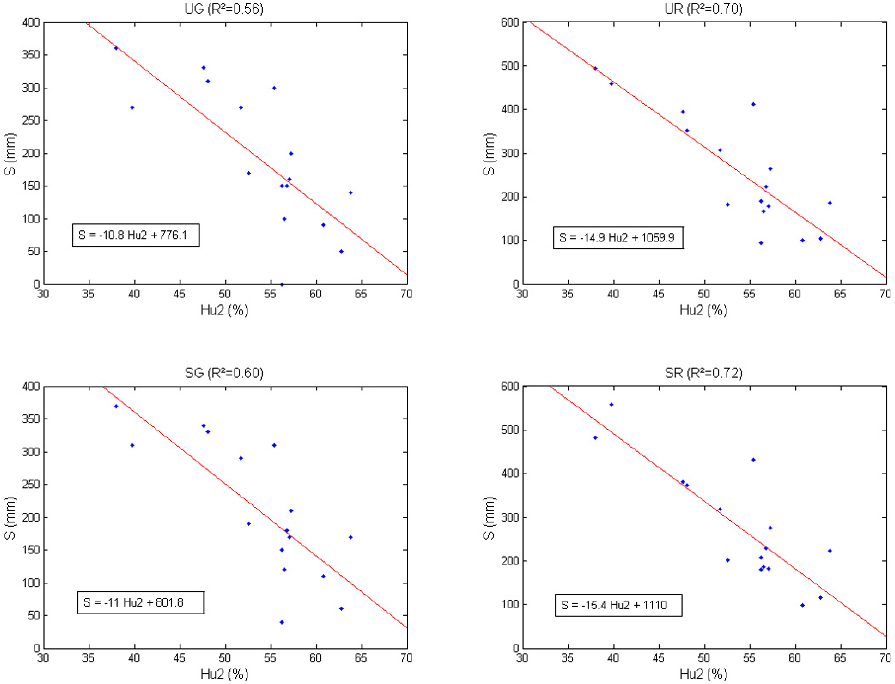
Fig. 9. Relation between S and Hu2 for each rainfall